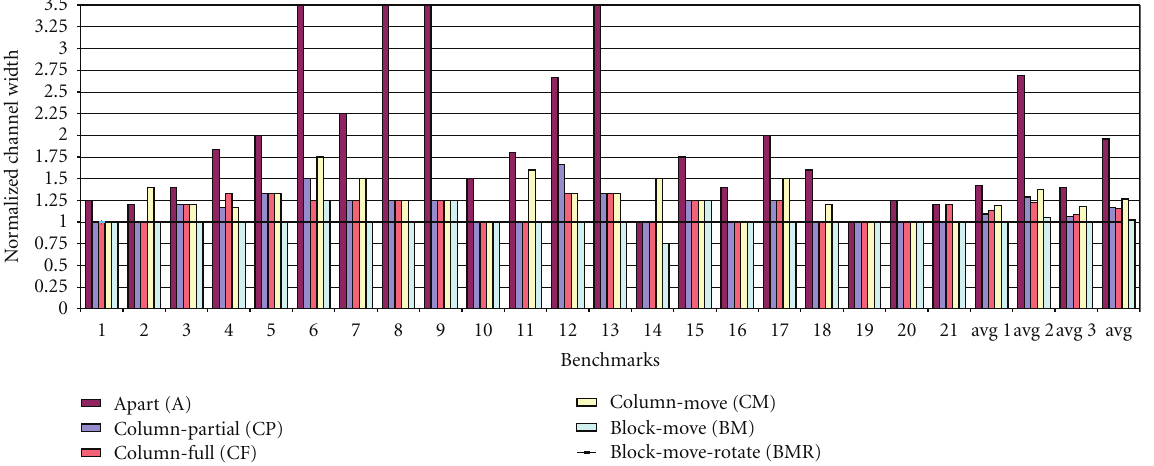
Figure 11: Channel width comparison between di ff erent techniques of mesh-based